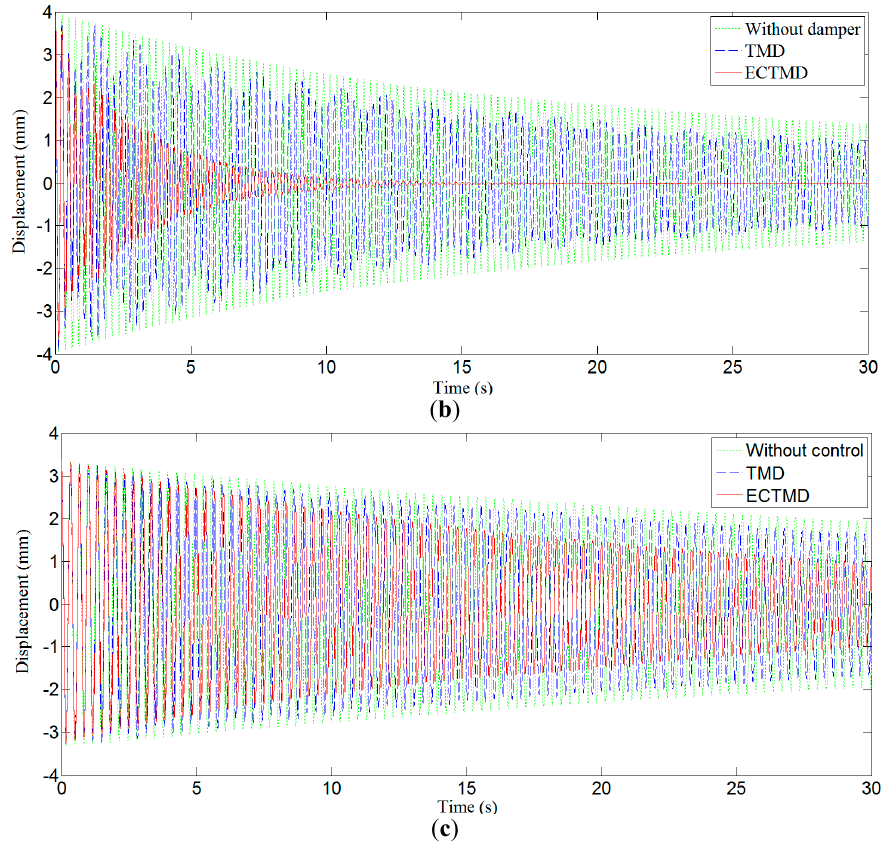
Figure 5. Free vibration responses of the cantilever beam in different situations. ( a ) Detuned ratio 0%; ( b ) Detuned ratio 14.7%; ( c ) Detuned ratio − 13.3%.